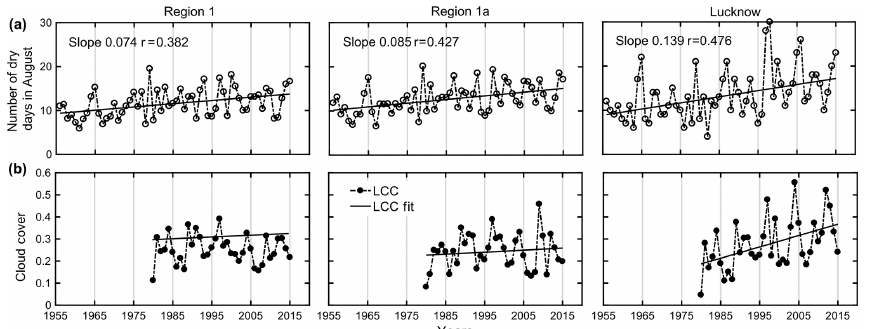
Figure 6. Statistical comparison of the climatology of all parameters during August for region 1, region 1a, Lucknow during various time spans (a) dry day frequency values between 1956–2015 and (b) Low cloud cover during